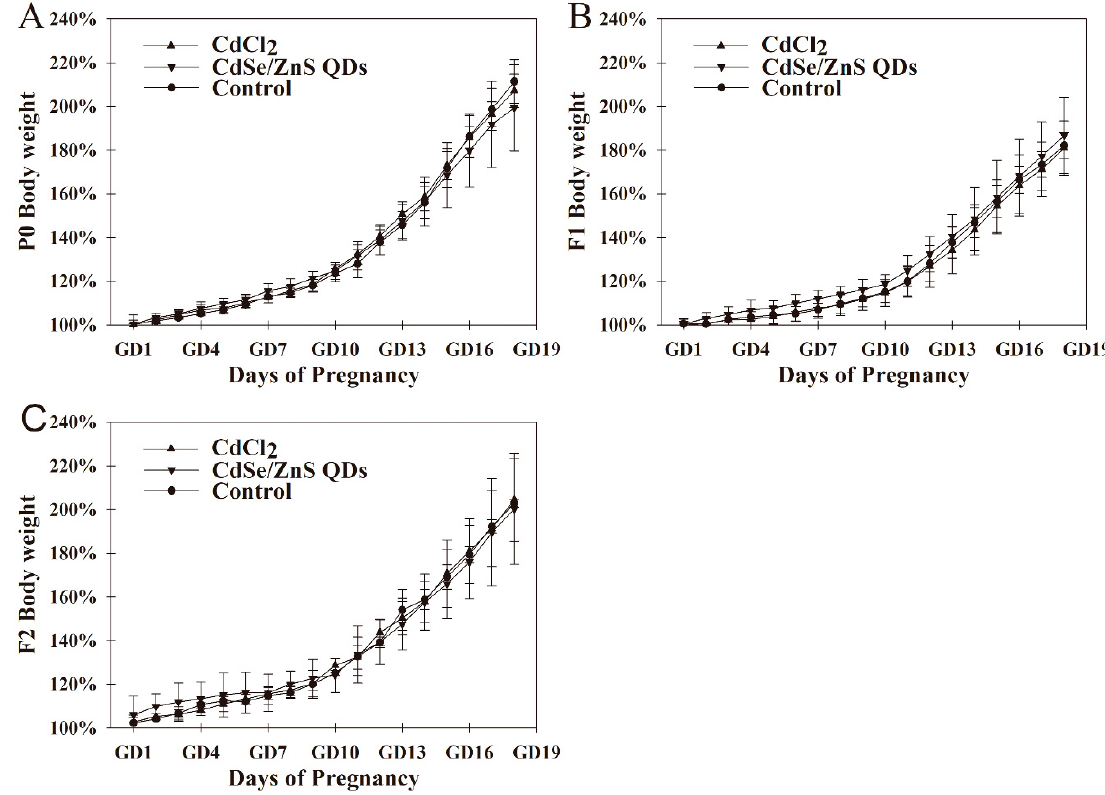
Figure 2. Average body weights of three generational pregnant mice. ( A ), ( B ), ( C ) show changes in maternal body weight of P0, F1, F2, respectively; the body weight of pregnant mice were presented as a percentage of the weight while vaginal plug appeared (GD 0) (= 100%). These data are presented as the mean and SD, n = 6.